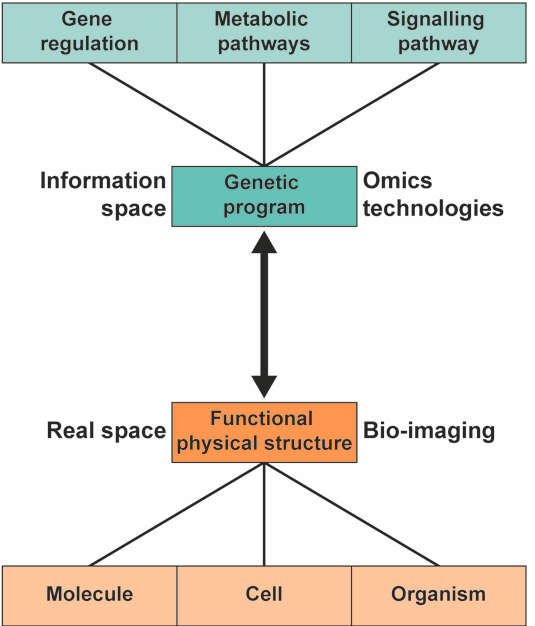
Figure 1. In systems biology, the information from the genetic program is integrated with information from functional physical structures to provide a comprehensive model of plants.